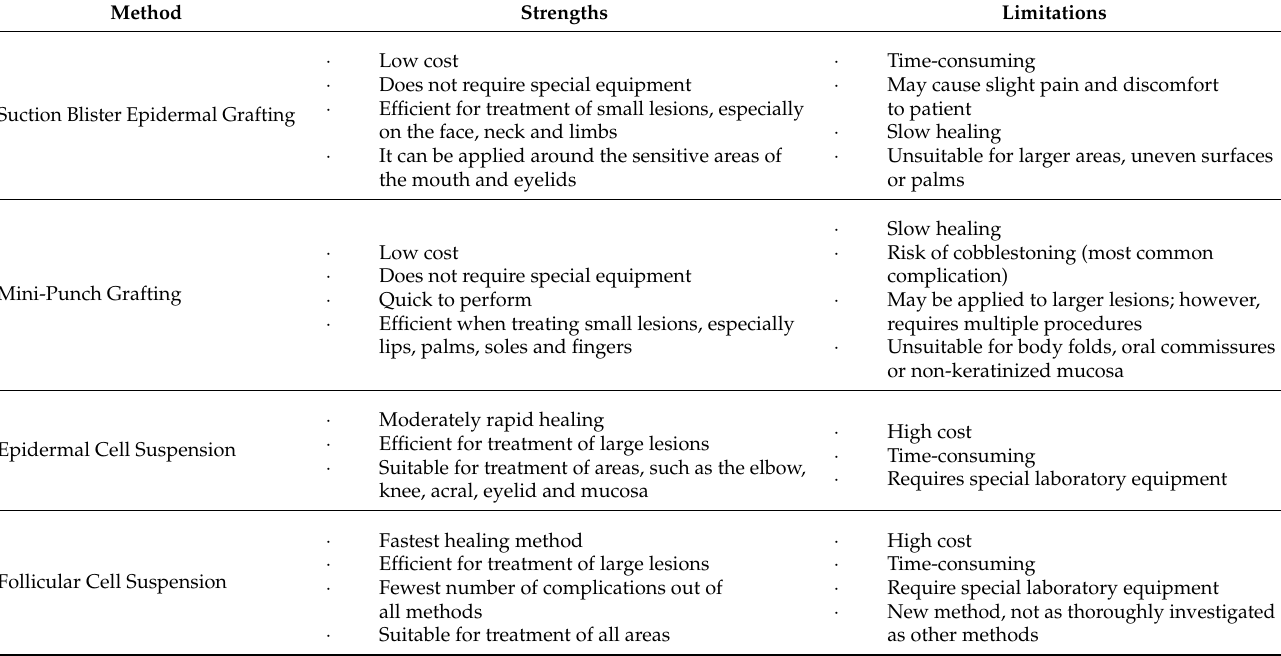
Table 2. Strengths and limitations of reported